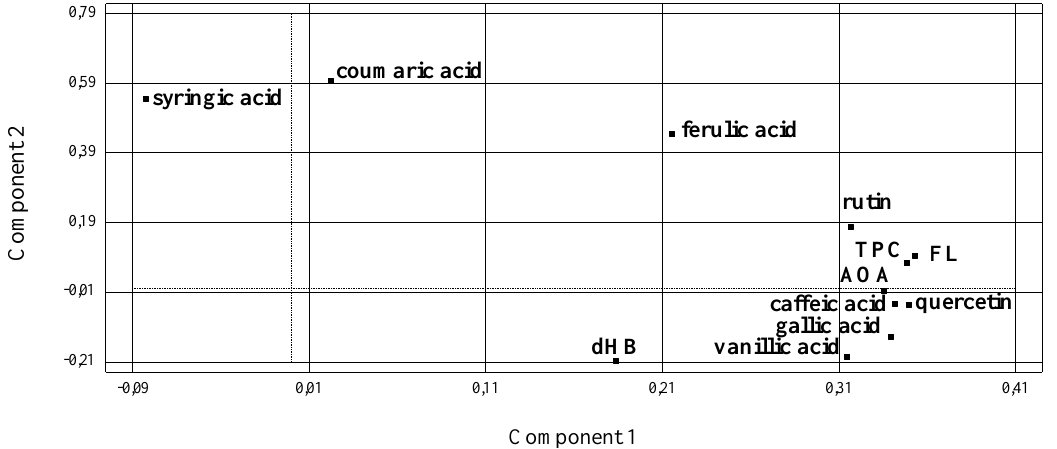
Figure 3. Loadings of variables studied in coordinates PC1 and PC2. TPC: total phenolic content; FL: total flavonoid content; AOA: antioxidant activity; dHB: protocatechuic acid.